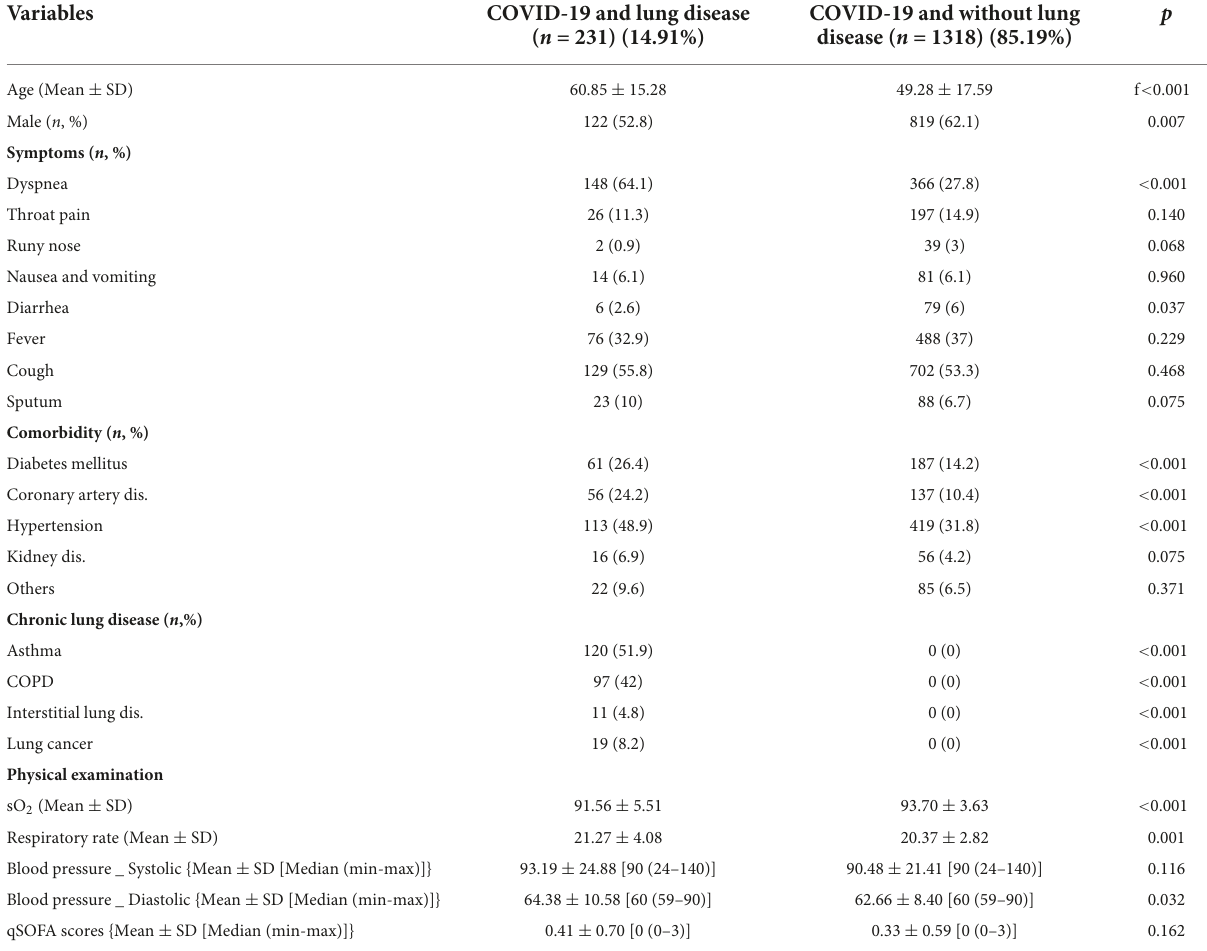
TABLE 1 Demographic parameter of patients with chronic disease (Group 1) and without chronic lung disease (Group 2). Variables COVID-19 and lung disease ( n = 231)